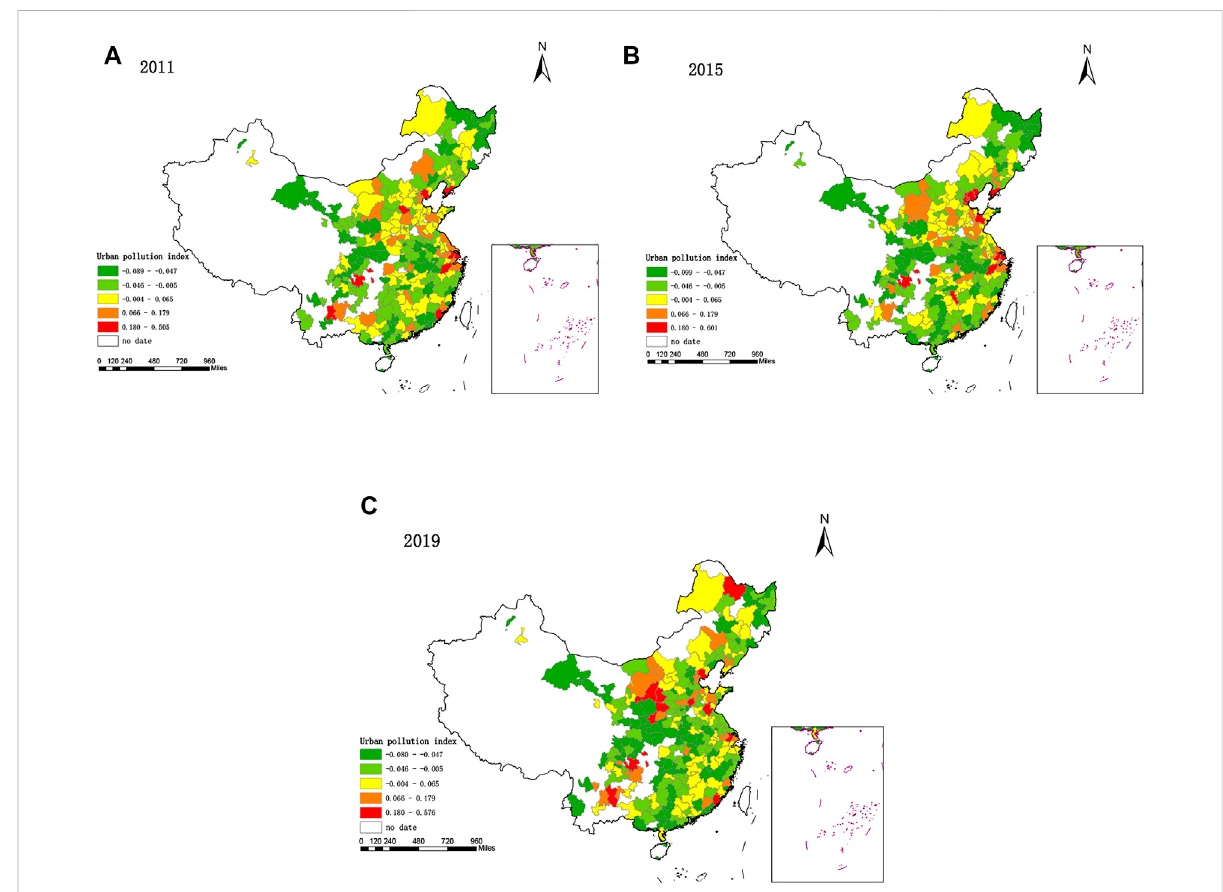
FIGURE 4 Spatial and temporal evolution of China ’ s urban pollution composite index in 2011 (A) , 2015 (B) , and 2019 (C) .